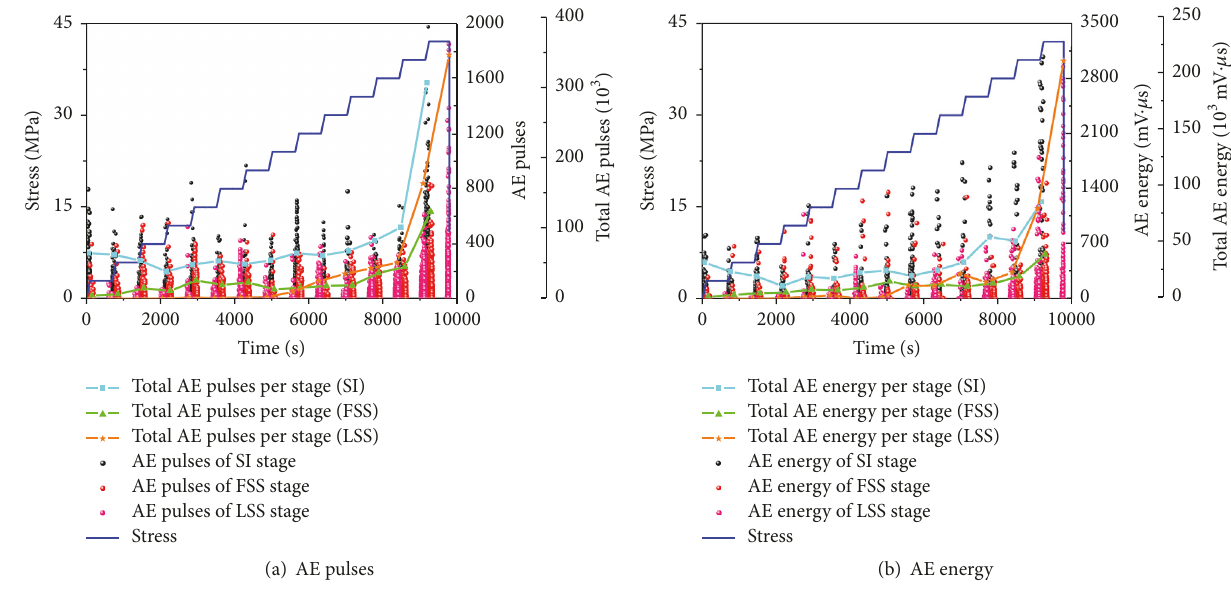
Figure 5: AE time-varying characteristics of concrete under step loading.